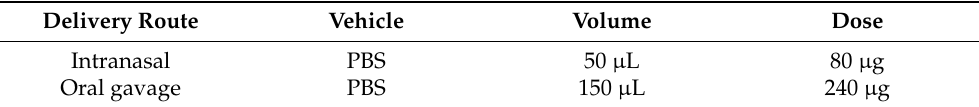
Table 1. DMF Formulation